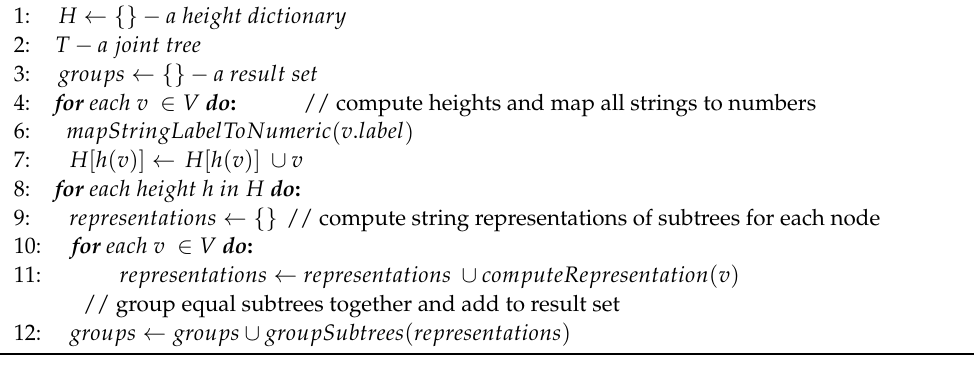
Algorithm 1: Main idea of the base algorithm of an equal subtree search in pseudocode. The base algorithm of an equal subtree search